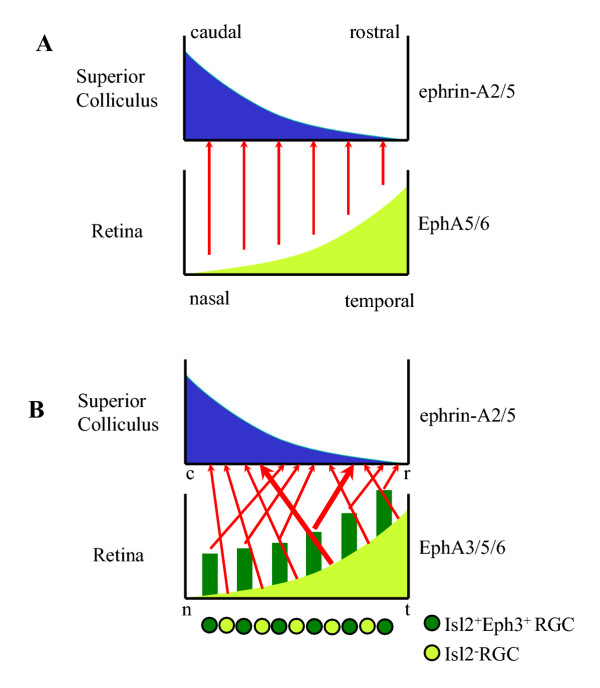
Chemical labelling system in retinocollicular map in mice A. Formation of the map in the wild-type mouse. Retinal ganglion cells (RGC) express EphA5/6 receptors in temporal > nasal gradient (bottom), whereas the cells in SC express the ephrin-A ligands in caudal > rostral gradient (top). Since axons of Eph+ RGC (red arrows) are repelled by ephrins this distribution of chemical markers leads to establishing of ordered topographic map in which nasal/temporal retina projects to caudal/rostral SC. This is because RGC axons expressing highest levels of Eph receptors (temporal) experience the largest repulsion and are expelled to the rostral part of SC, where such repulsion is minimal. Axons of nasal RGC are more indifferent to the action of ligands and occupy more caudal positions. Such system allows positioning of RGC axons in the order of increasing expression level of EphA receptors. B. Map in the mutant mouse from Ref. [20]. The expression level of EphA receptors was artificially increased in every second cell by genetic manipulations (dark gray). This is done by co expressing EphA3, which is absent in the wild-type RGCs (see A), with another gene, Isl2, which is expressed roughly in 50% of RGCs. Since ephrin ligands bind and activate all receptors from EphA family, albeit with different affinity, this results in anomalous projection to SC, based roughly on the total levels of EphA in each axon. Similarly to A this leads to sorting of axons in the order of increasing density of EphAs (red arrows). Note that two RGC neighboring in retina become separated in SC (bold arrows). This aberration in the topographic map leads to two termination zones (TZs) in SC for two neighboring cells in retina, rather than a single zone in wild-type [20].